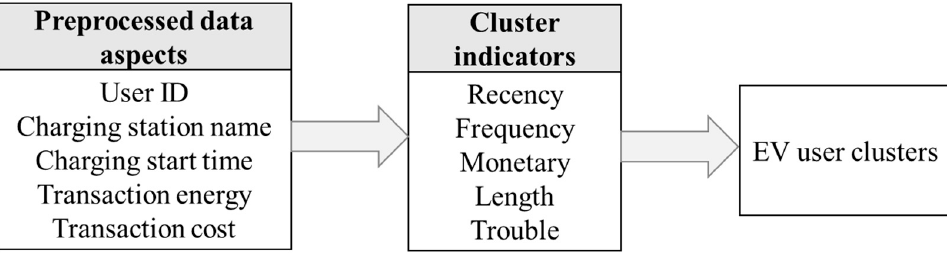
Figure 9. Overview of hybrid method for EV clustering proposed in [61]. 3.1.4. Other Methods There have been other clustering methods used to group EVs according to user be- havior. For example, Powell et al. [62] used agglomerative clustering to classify drivers in ascending order. Each driver is assigned to its cluster at initialization, and the method joins two clusters at each step. The selection of clusters to merge is based on minimizing the increase in the sum of squares within the cluster. Similarly, Campbell et al. [3] used the Wards cluster analysis approach to census data (based on age, income, automobile ownership, property ownership, socioeconomic status, and education) to discover pro- spective drivers of alternative fuel vehicles in Birmingham, United Kingdom. The sum of squares (distance) between an item in the first cluster and an object in the second clus- ter is calculated using Ward’s approach and then totaled over all variables. This strategy maximizes the formation of clusters of roughly equal proportions. An overview of the clustering approach used in [3] is shown in Figure 10.